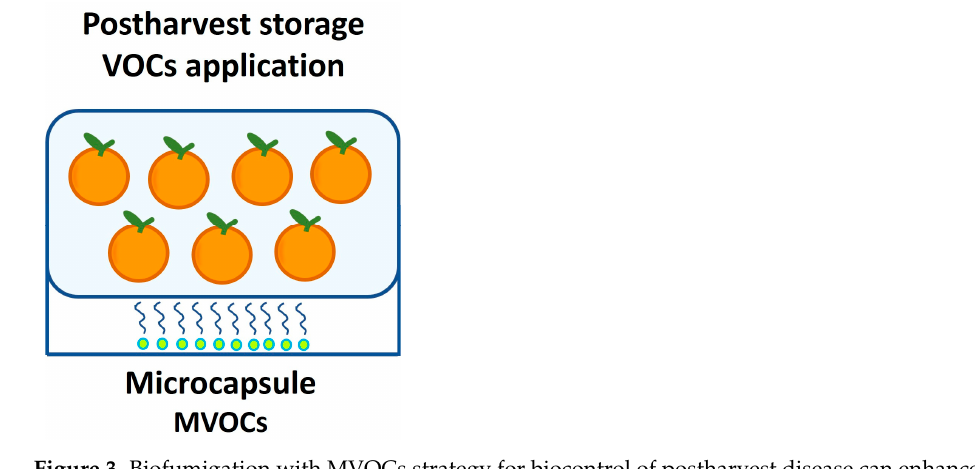
Figure 3. Biofumigation with MVOCs strategy for biocontrol of postharvest disease can enhance the shelf-life and quality of food. Table 1. Microbial volatile organic compounds with application in postharvest diseases control.